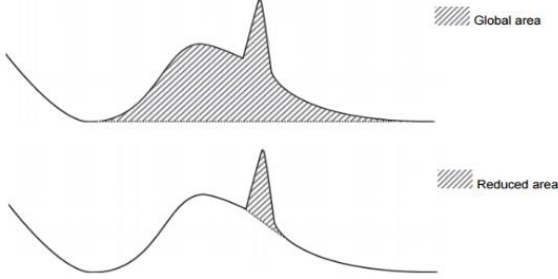
Figure 1. Global and reduced area under an XRD scan.